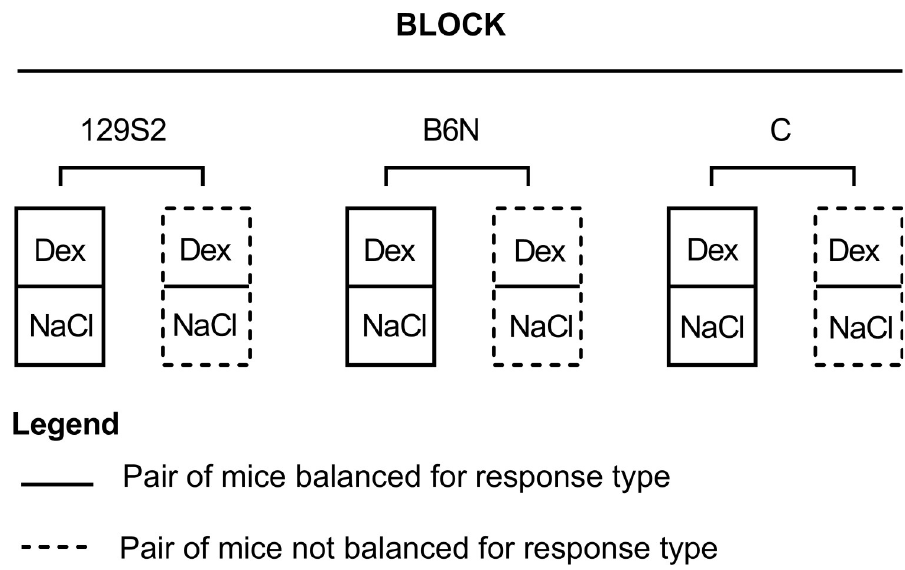
Fig 2. Schematic overview of the 2 (treatment) x 3 (strain) x 2 (experimenter) factorial complete randomized block design used in the pharmacological experiment. Overview represents a single block, for one experimenter. Pairs in the balanced condition were matched on weight and individual response type. Pairs in the unbalanced condition were only matched on weight. The unbalanced condition mimicked a ‘regular’ animal experiment in which individual response type is not taken into account in assignment to experimental groups. Pairs in the unbalanced condition could therefore consist of one animal from cluster A, and one animal from cluster B, or consist of two animals from the same cluster. Pairs in the balanced condition only consisted of two animals of the same cluster. Within each of 4 blocks (4 testing days) for each experimenter, all pairs were matched within strain, and within experimenter. Dex = treatment with dexmedetomidine (Dexdomitor 1 , 10 μ g/kg, 100 μ l, i . p ); NaCl = control treatment with saline (NaCl, 0.9%, 100 μ l, i . p ).